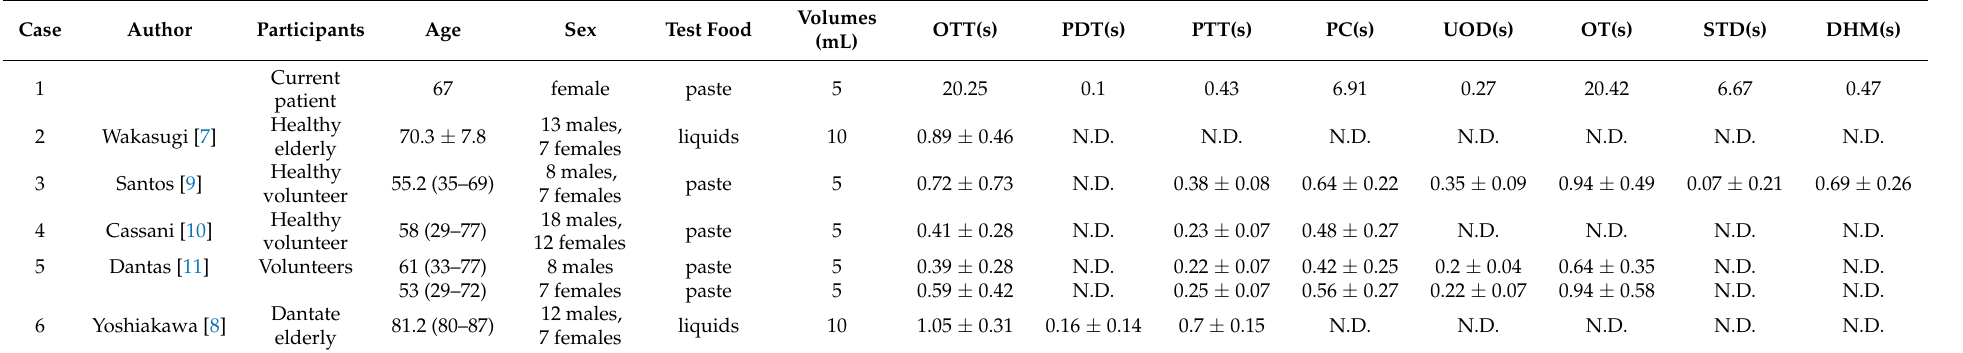
Table 1. Comparison of swallowing function between our patient and healthy adults.